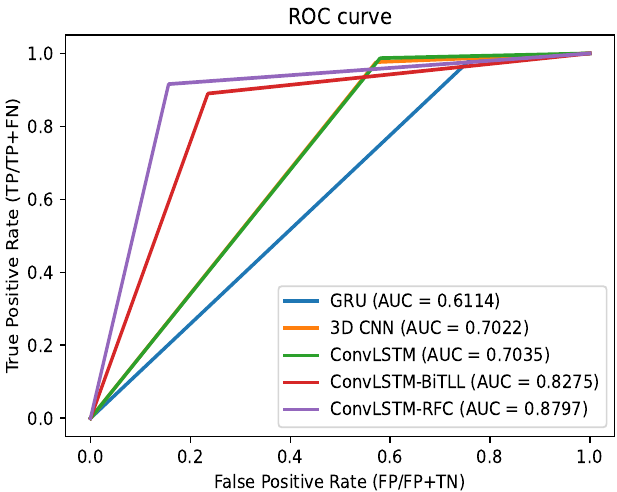
Figure 7. ROC curve of all the